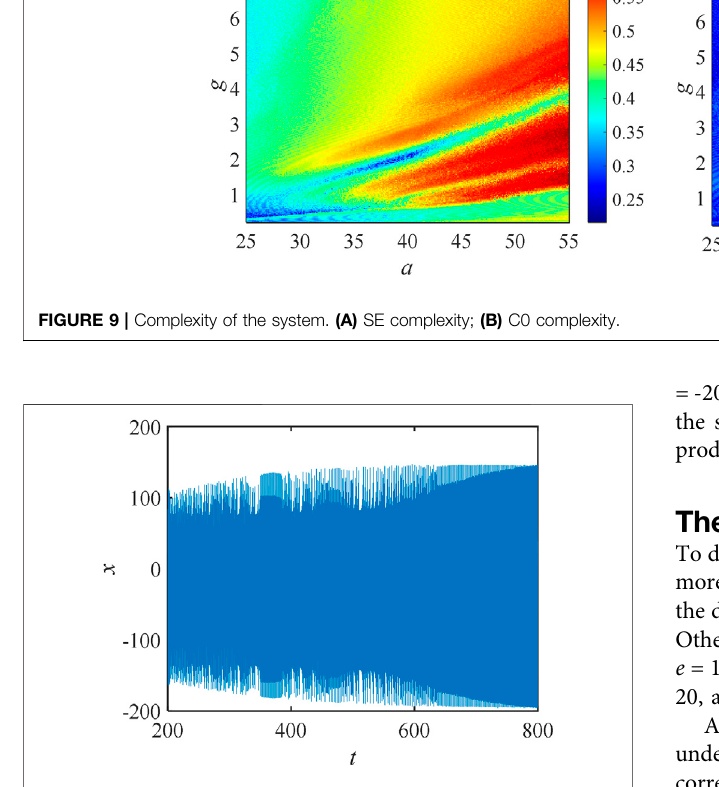
FIGURE 10 | Timing diagram with time t =(200,